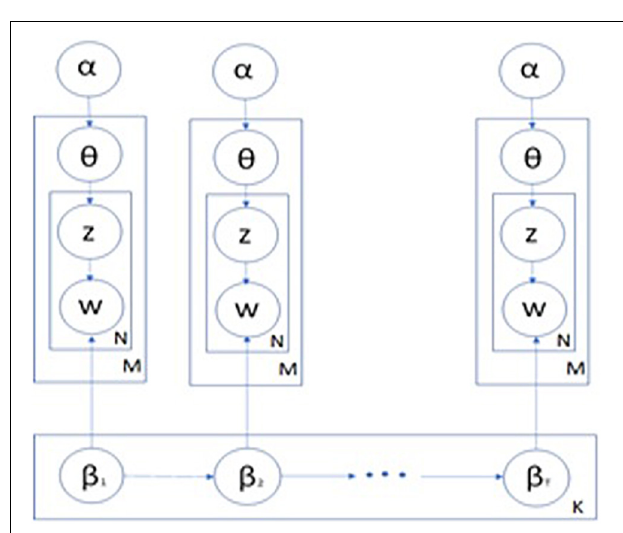
FIGURE 4 | Plate notation representing